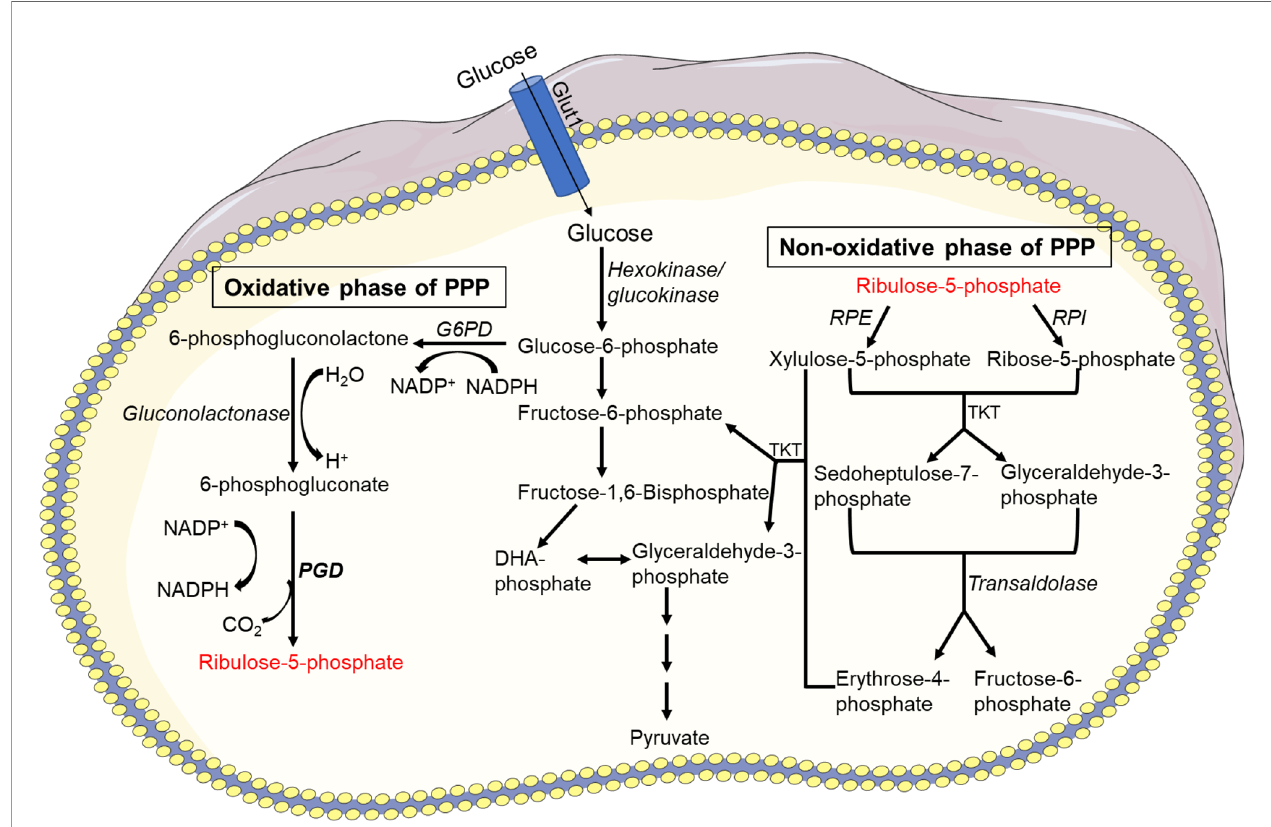
FIGURE 2 | Pentose phosphate pathway (PPP). There are two phases in the PPP: oxidative and non-oxidative. G6P-dehydrogenase (G6PD), 6- phosphogluconolactonase, and 6-phosphogluconate dehydrogenase (PGD) convert G6P into CO 2 , ribulose-5-phosphate, and NADPH during the oxidative phase to maintain redox balance under stressful conditions. In the non-oxidative phase, enzymes such as ribose-5-phosphate isomerase, ribulose-5-phosphate 3-epimerase, a transketolase, and a transaldolase convert ribulose-5-phosphate to nucleic acids, sugar phosphate precursors, or glycolytic precursors such as fructose-6- phosphate (F6P) and glyceraldehyde-3-phosphate (G3P). PPP and glycolysis share a pool of G3P and F6P, resulting in lactate or pyruvate